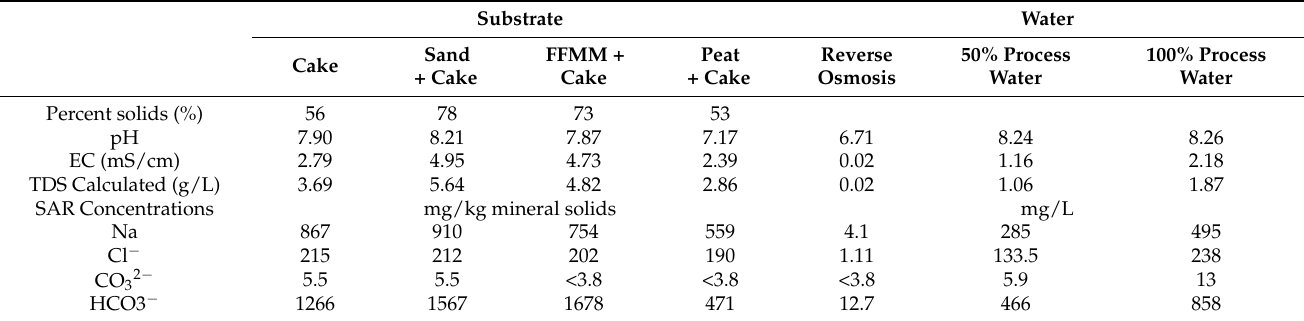
Table 1. Chemical characteristics of substrates and process water used for plant growth. EC, TDS, and SAR represent electrical conductivity, total dissolved solids and sodium adsorption ratio,